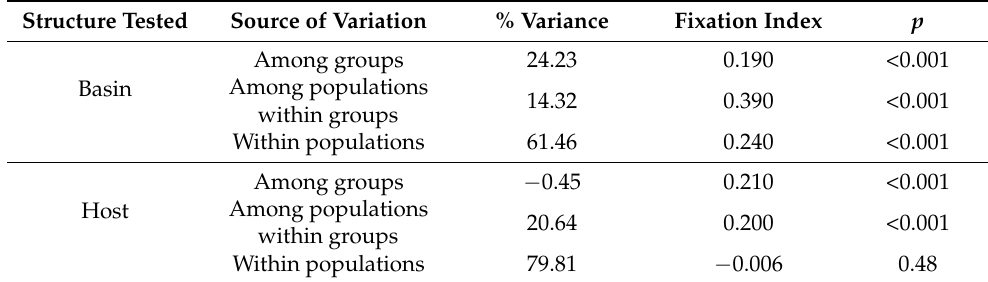
Table 2. Analysis of molecular variance (AMOVA) measured among populations of Margaritifera margaritifera , delineated by the corresponding sea basin, and among populations from the north- eastern part of the range related to different fish hosts (see text for details). Structure Tested Source of Variation % Variance Fixation Index p Among groups Among populations Basin within groups Within populations Among groups Among populations within